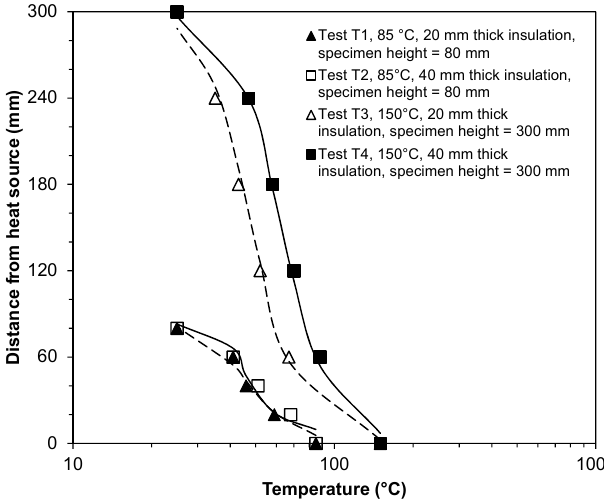
Figure 4. Temperature profiles in the non-isothermal tests at 85 °C and 150 °C with various thicknesses of insulation.